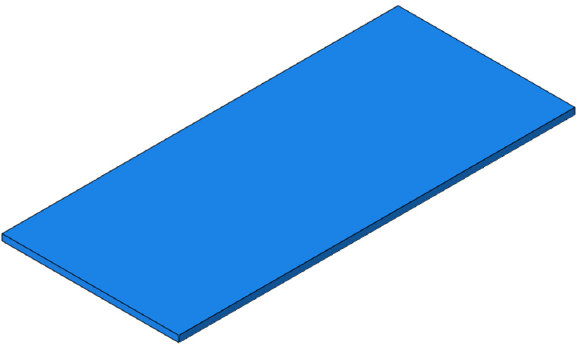
For the CP, the joint between the SCC layer and the track slab is completely separated, and the whole interface is connected only by the U-shaped ribs, with a parting height of 2 mm, as shown in Figure 24. The dynamic performance of the track structure under the condition is analyzed.